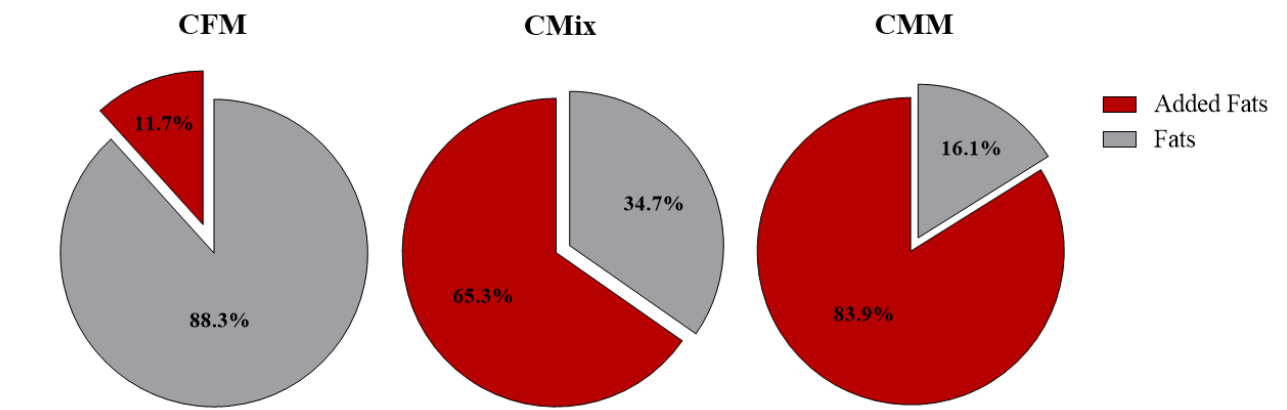
Figure 3. Crude fat composition, expressed as percentages, of CFM, CMix, and CMM formulations for companion animal food. Data are reported as mean, n =